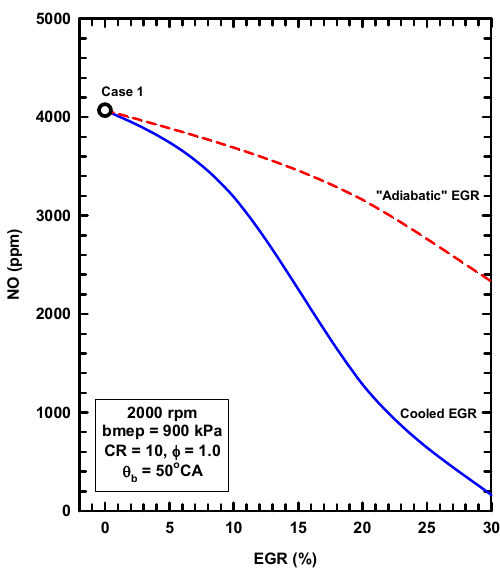
Figure 12. Nitric oxide concentrations as functions of the EGR percentage for the two EGR configurations.